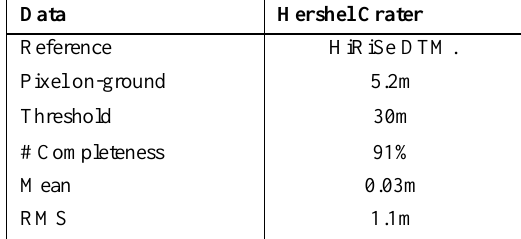
Table 1 Reconstruction performance of the SW